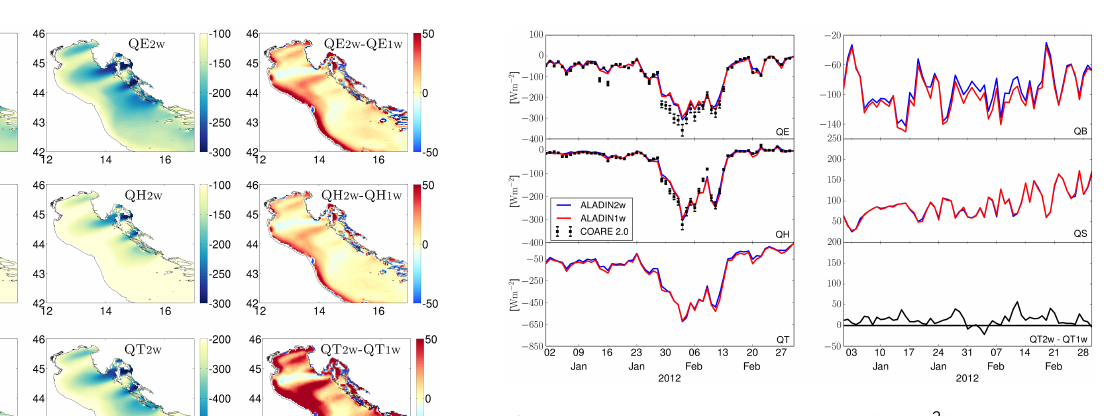
Figure 6. Daily averages of bulk fluxes [Wm − 2 ] at Vida location from ALADIN1w (red line) and ALADIN2w (blue line). Sensible and latent heat fluxes at Vida location were computed using COARE 2.0 algorithm from measurements at Vida: daily averages of these fluxes are depicted with black squares with vertical error bars (see text for details on error estimation). Top left: Q E – latent heat flux. Middle left: Q H – sensible heat flux. Bottom left: Q T – total heat flux. Top right: Q B – long-wave downward radiation. Middle right: Q S – Solar shortwave radiation. Bottom right: Q T2w − Q T1w – total heat flux difference between ALADIN2w and ALADIN1w. Fluxes are depicted as negative when the ocean is losing